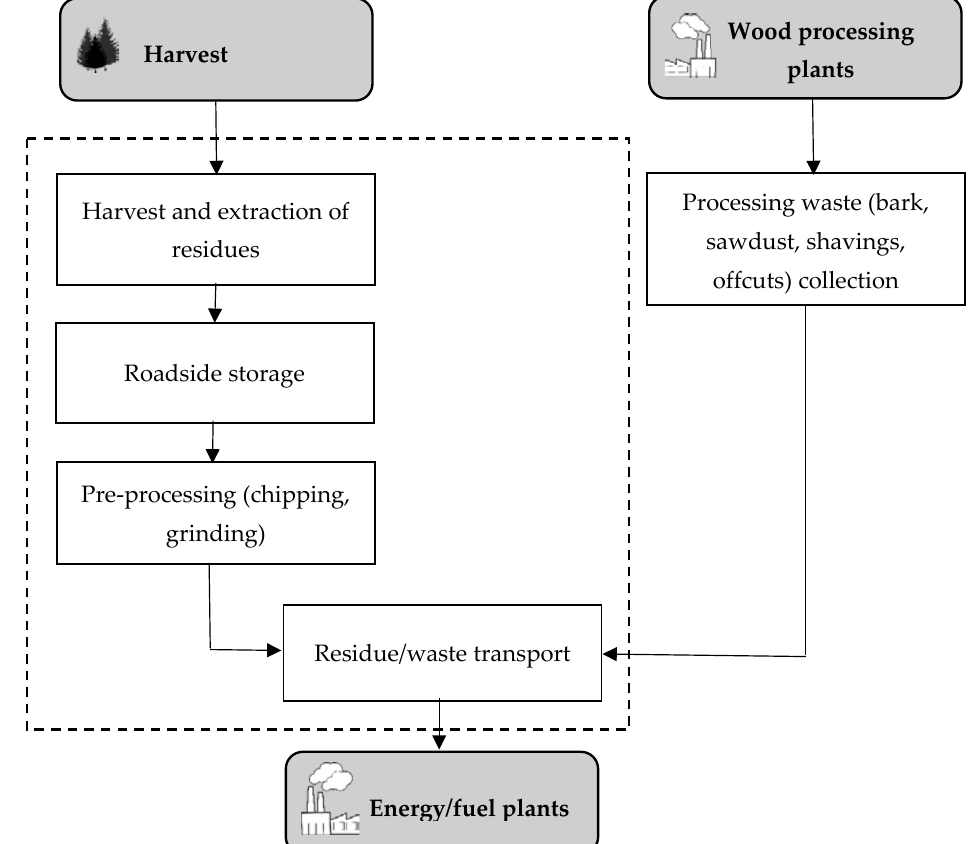
Figure 1. Biomass supply chain showing the major activities. Activities in the dashed box are included in the current DSS.